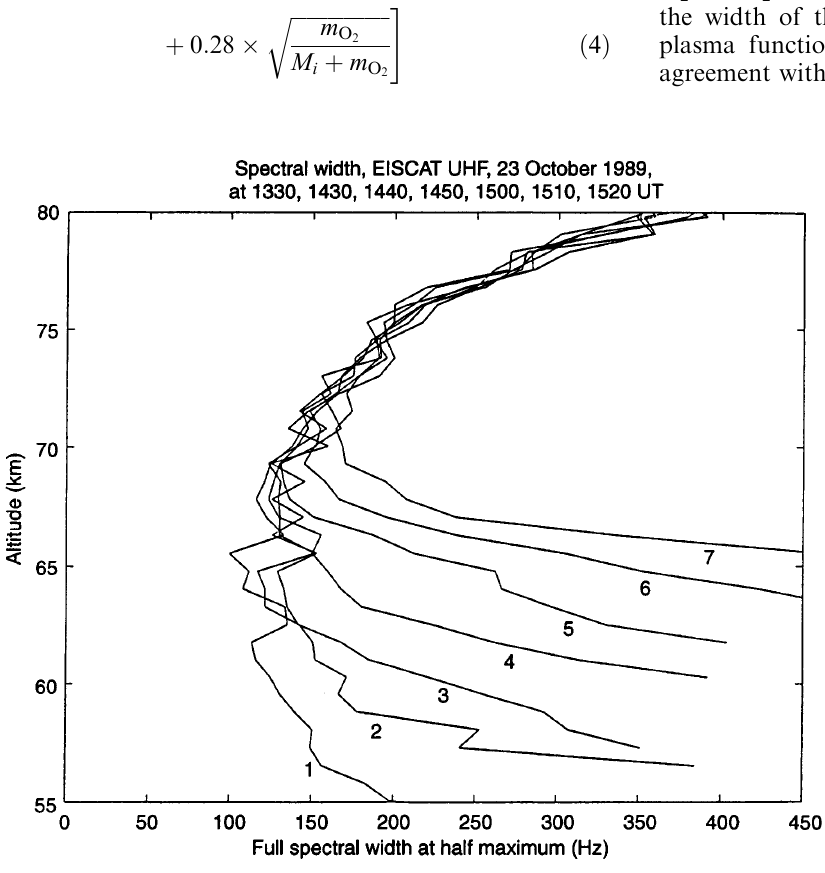
Fig. 2. Raw electron density profiles (in m (cid:255) 3 ) from EISCAT measurements of the proton precipitation event during sunset on 23 October, 1989. The numbers on the curves identify, in increasing order, the zenith angles (and UT) of the individual determinations: 87 : 1 (cid:14) (1330), 91 : 1 (cid:14) (1430), 91 : 9 (cid:14) (1440), 92 : 6 (cid:14) (1450), 93 : 4 (cid:14) (1500), 94 : 2 (cid:14) (1510), and 95 : 1 (cid:14) (1520)